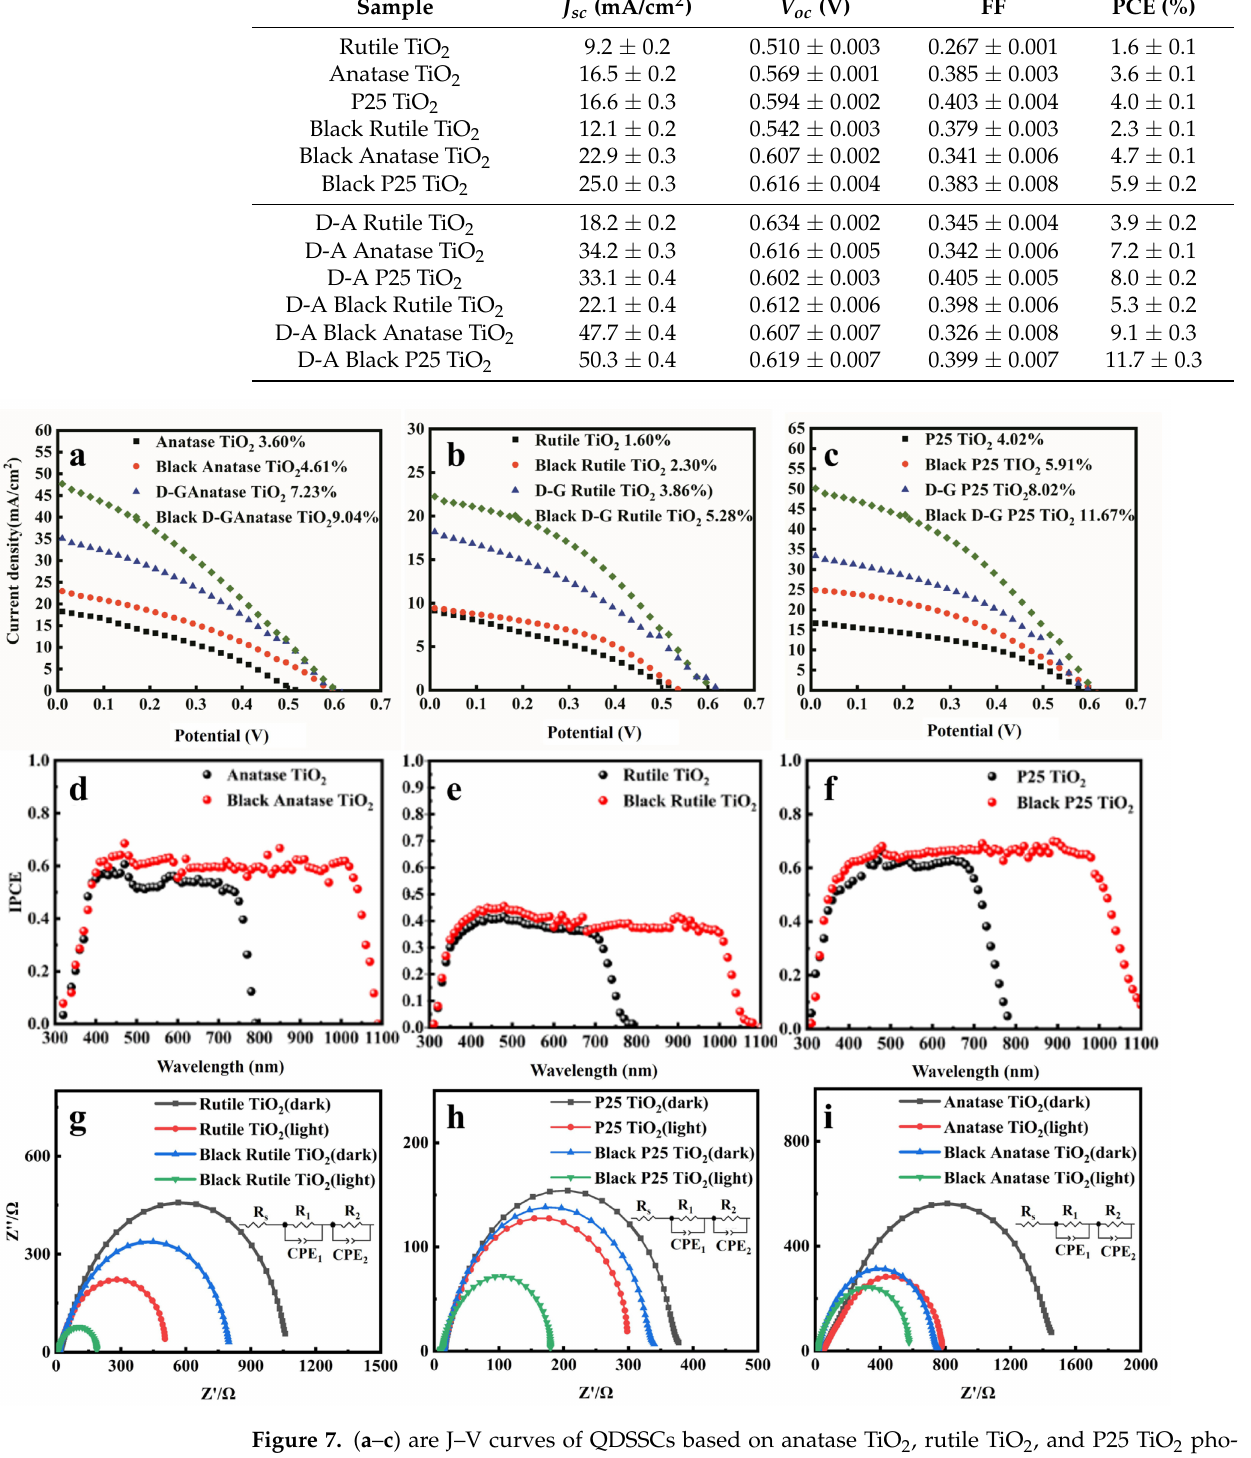
Figure 7. ( a – c ) are J–V curves of QDSSCs based on anatase TiO 2 , rutile TiO 2 , and P25 TiO 2 pho- toanodes with and without laser treatment, respectively; ( d – f ) are IPCE curves of QDSSCs based on anatase TiO 2 , rutile TiO 2 , and P25 TiO 2 photoanodes with and without laser treatment, respectively; ( g – i ) are Nyquist curves of anatase TiO 2 , rutile TiO 2 , and P25 TiO 2 photoanodes with and without laser treatment measured in the dark and under illumination,